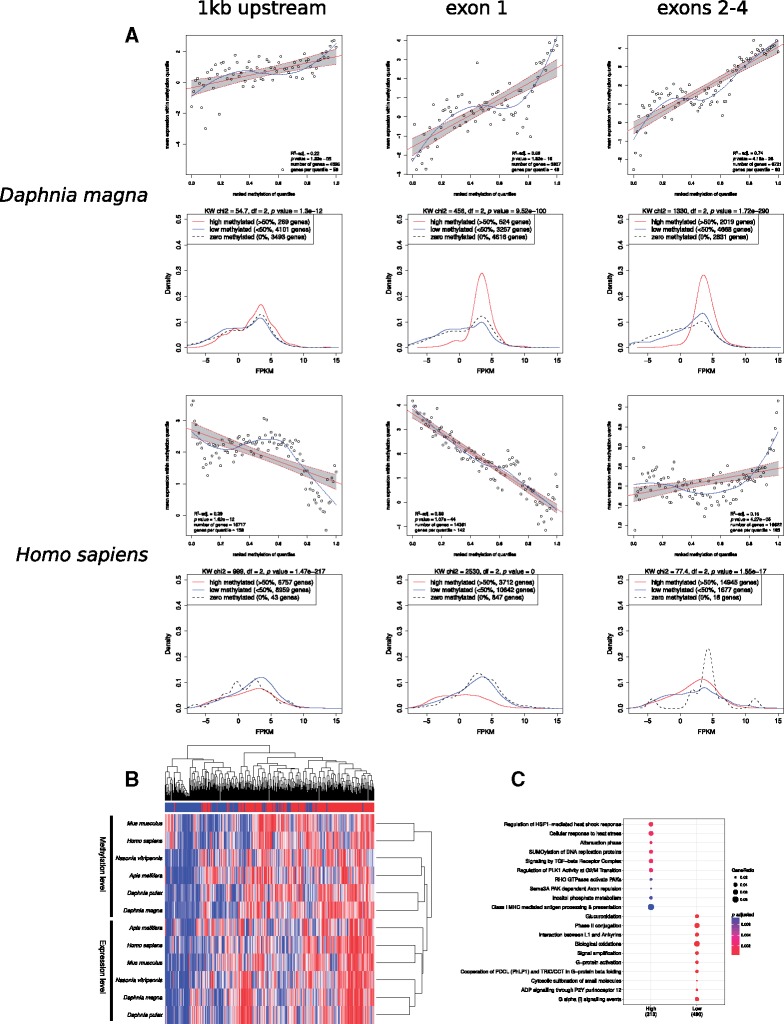
—Correlation analysis of gene expression and DNA methylation data. (A) Top panel per species: regression of gene expression and methylation levels across genomic features (1 kb upstream of first exon, exon 1, and exons 2–4). Linear regression and 95% confidence interval marked in red. A loess fit is shown in blue. The legend shows R2 and P value for the linear regression as well as the number of genes used in the analysis and the average number of genes in each quantile. The methylation levels of genes were ranked and the gene expressions were averaged for all genes within the same methylation quantile. Bottom panel per species: density plots of genes relative to their expression level (FPKM). The high methylated genes (red) are over-abundant in the high expression range, in all the features show, compared to LM (blue) and non-methylated (black) genes in arthropods (D. magna). Whereas the vertebrates (H. sapiens) show over-abundance of high methylated genes only in exons 2–4. In exon 1 and 1 kb upstream from the first exons vertebrates have the opposite pattern; over-abundance of LM genes in the high expression range. Differences in the expression densities among methylation states are analyzed with Kruskal–Wallis sum rank test. (B) Heatmap of rank ordered mean methylation and mean expression level of genes belonging to the same cluster of orthologous genes (414 orthogroup). The methylation level was calculated from exons 2–4 in arthropods and exon 1 in vertebrates. In vertebrates, the rank order was reversed as methylation correlates negatively with gene expression (in exon 1). (C) Enrichment analysis of the two main clusters in the heatmap. The “High” cluster has high expression in most species and high methylation in arthropods (exons 2–4) and low methylation in vertebrates (exon 1). The “Low” cluster has low expression across species and low methylation in arthropods (exons 2–4) and high methylation in vertebrates (exon 1).